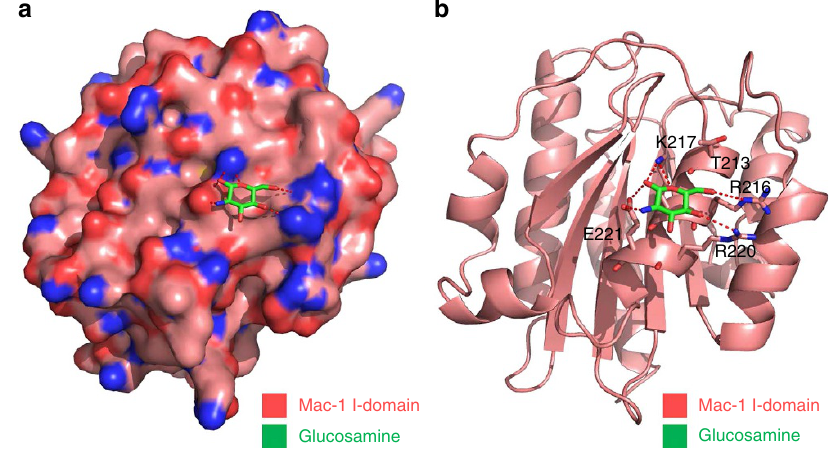
Figure 9 | Binding mode of glucosamine to a M I-domain of Mac-1. ( a ) Glucosamine binds to a small pocket on a M I-domain of Mac-1 (shown in surface presentation). ( b ) Key residues of the a M I-domain (cartoon presentation) potentially involved in the interaction with glucosamine (shown in stick mode). Potential H-bonds formed between a M I-domain and glucosamine are displayed by red dashed